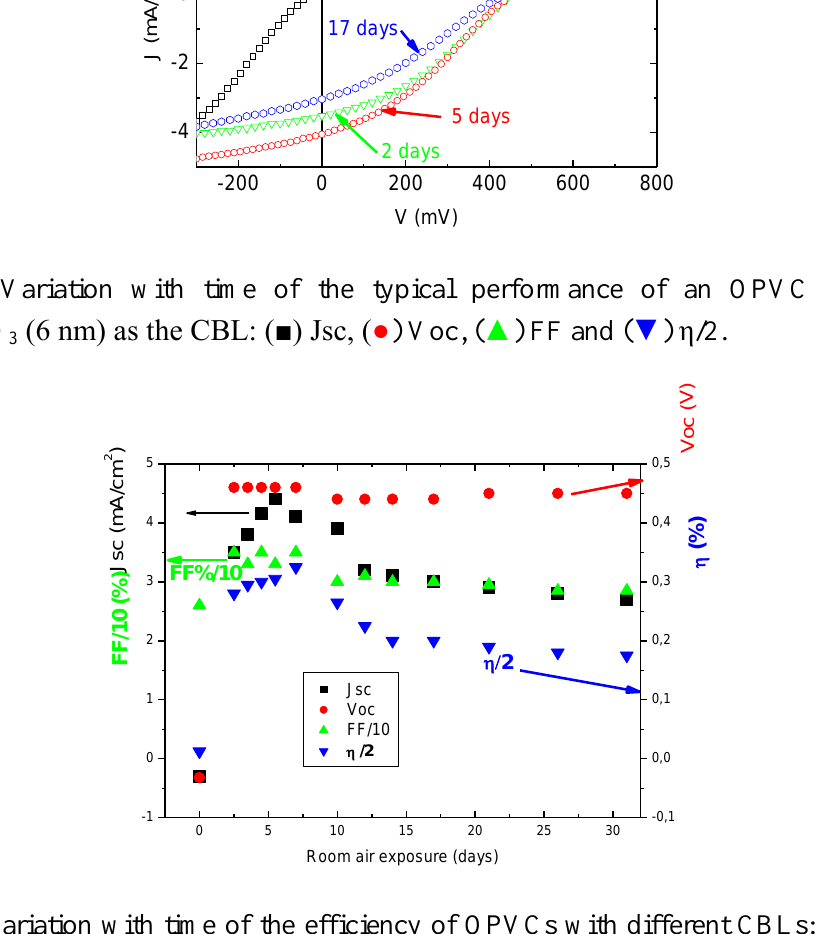
(6 nm)/MoO (3 nm); (▲) CBL = Alq 3 3